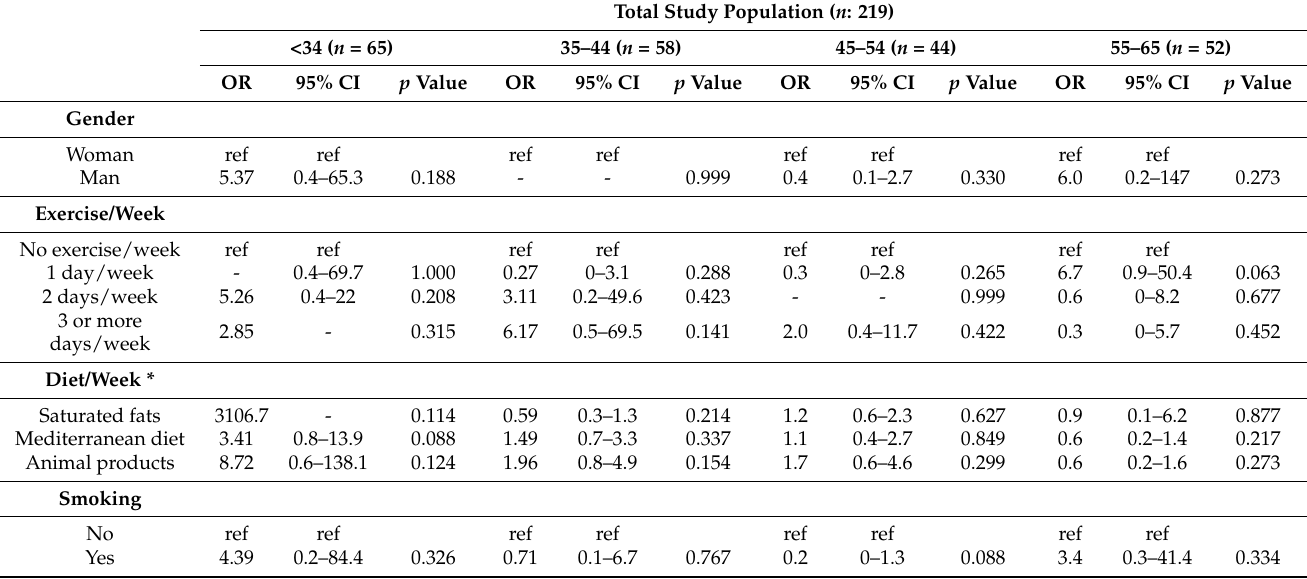
Table 6. Logistic regression considering shift work as a dependent variable stratifying by